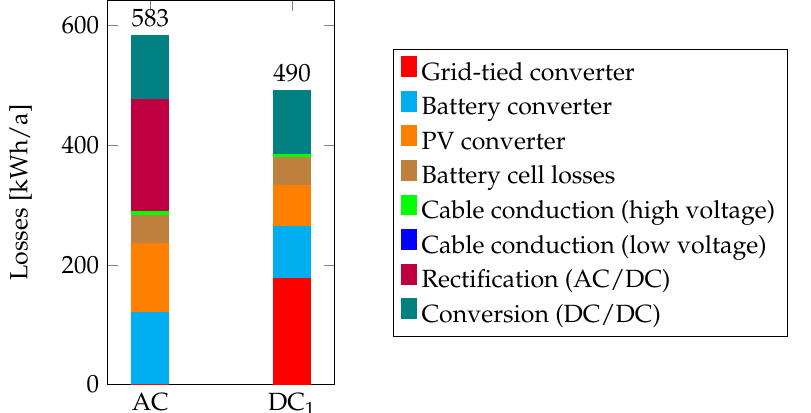
Figure 8. Annual system losses for a system configuration with 3.7 kWp PV array and 7.5 kWh battery storage. Low-voltage cable conduction was zero for both topologies but is included in the legend for consistency with the other figures.